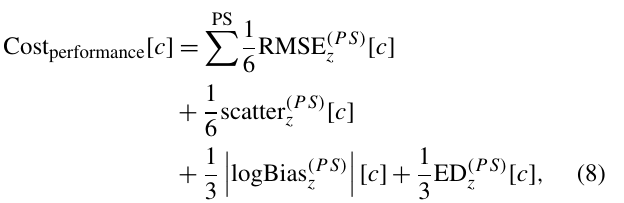
Figure 5. (a) Mean decrease in RMSE obtained with Algorithm 1 for all available features, separated for all precipitation and for R > 3mmh − 1 , and (b) relative importance of these RMSE decreases (normalized by the sum of all decreases). The importance of the feature Frac rad is the sum of the importance of the fraction of every single radar (see Sect.